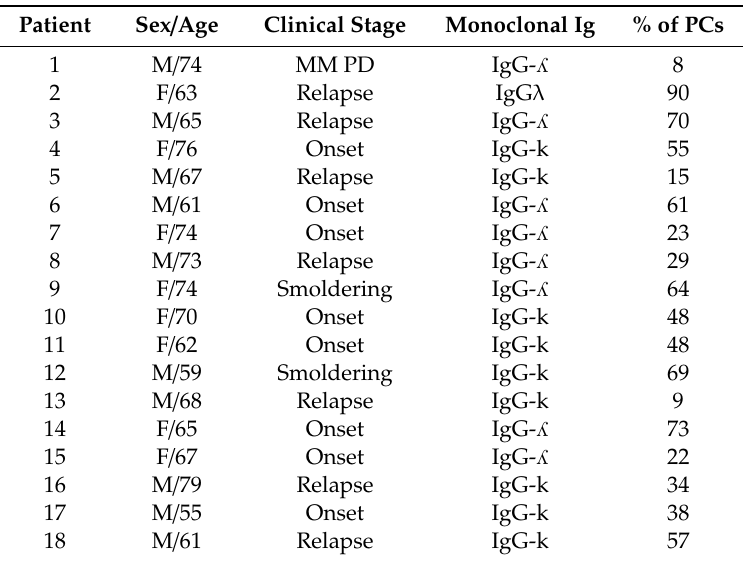
Table 2. Clinical parameters of MM patients used for the analysis of IL-8 production by BMSCs. Patients were classified according to Durie and Salmon’s Staging